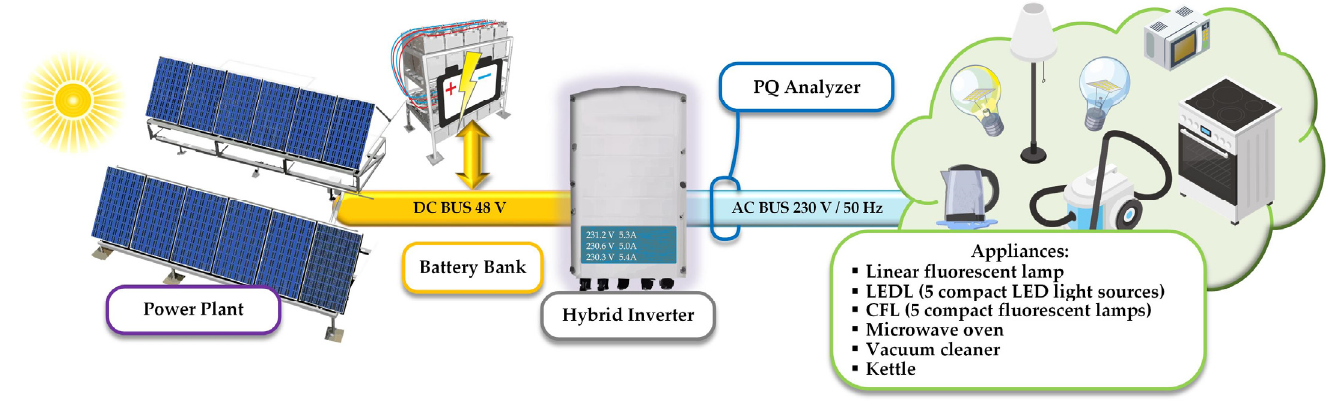
Figure 2. Scheme of the microgrid in which PLC system was tested.